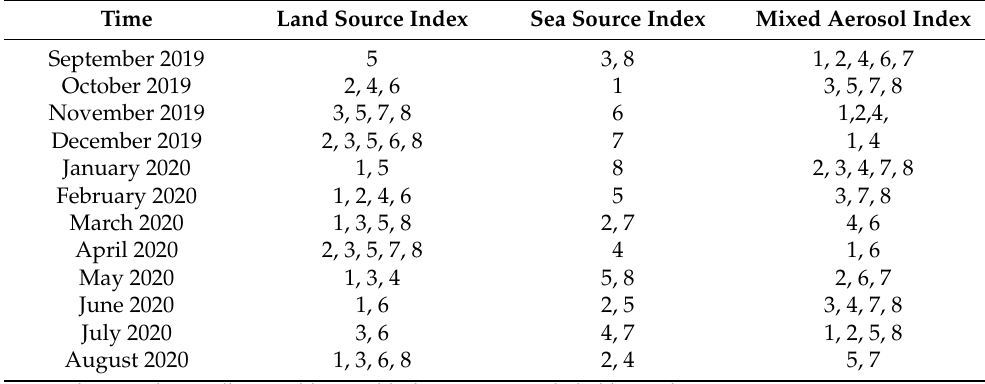
Table 2. Aerosol source index classification results from backward trajectory clustering. Time Land Source Index